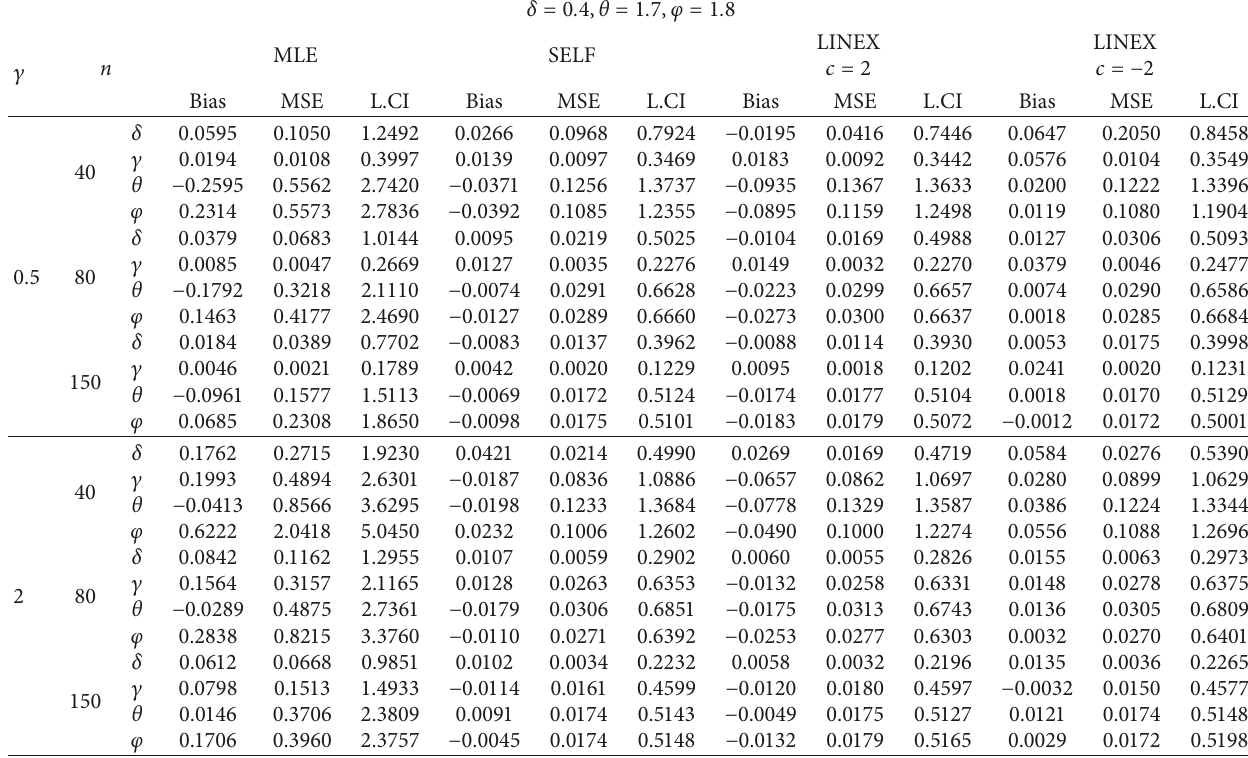
Table 5: Bias, MSE, and L. CI for MLE and BE for case